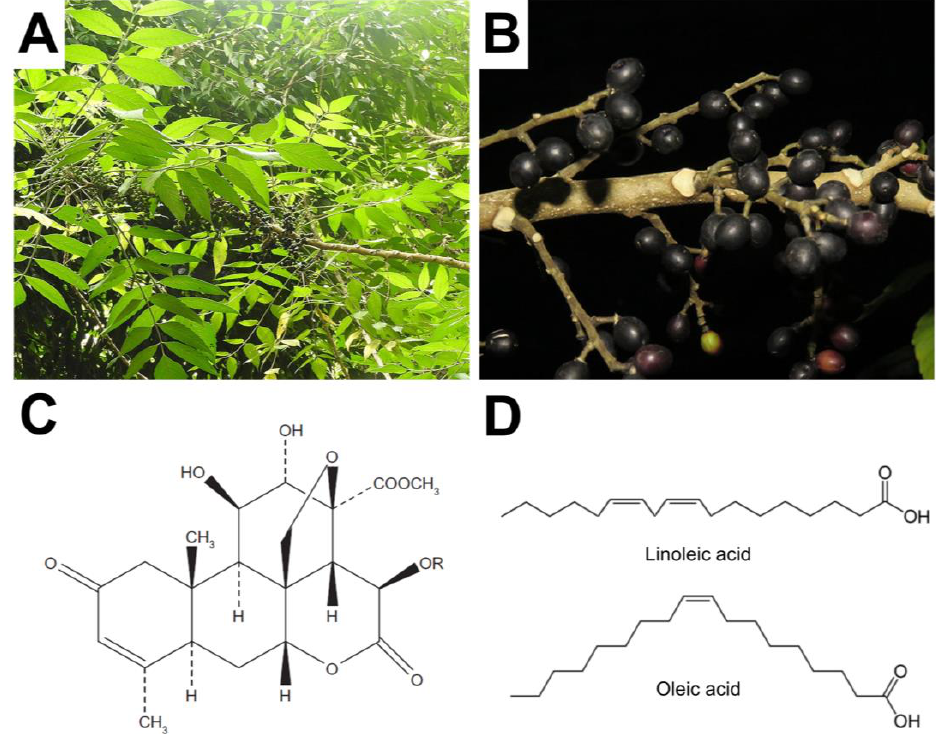
Figure 1. ( A ) Picture of Brucea javanica plant (Credit: Yercaud Elango under CC BY-SA 4.0 license); ( B ) Picture of Brucea javanica fruit (Credit: Ruben C. J. Lim under CC BY-NC-SA 2.0 license); ( C ) Chemical structure of a quassinoid molecule, where R denotes a generic substituent group; ( D ) Chemical structures of linoleic acid and oleic acid molecules. Reproduced with permission from Ref. [4].